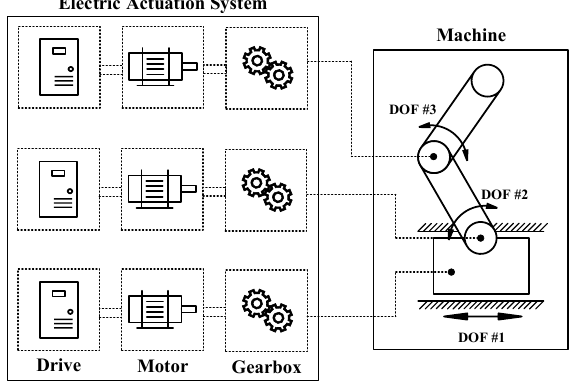
Figure 1: Conceptual representation of electric actua- tion